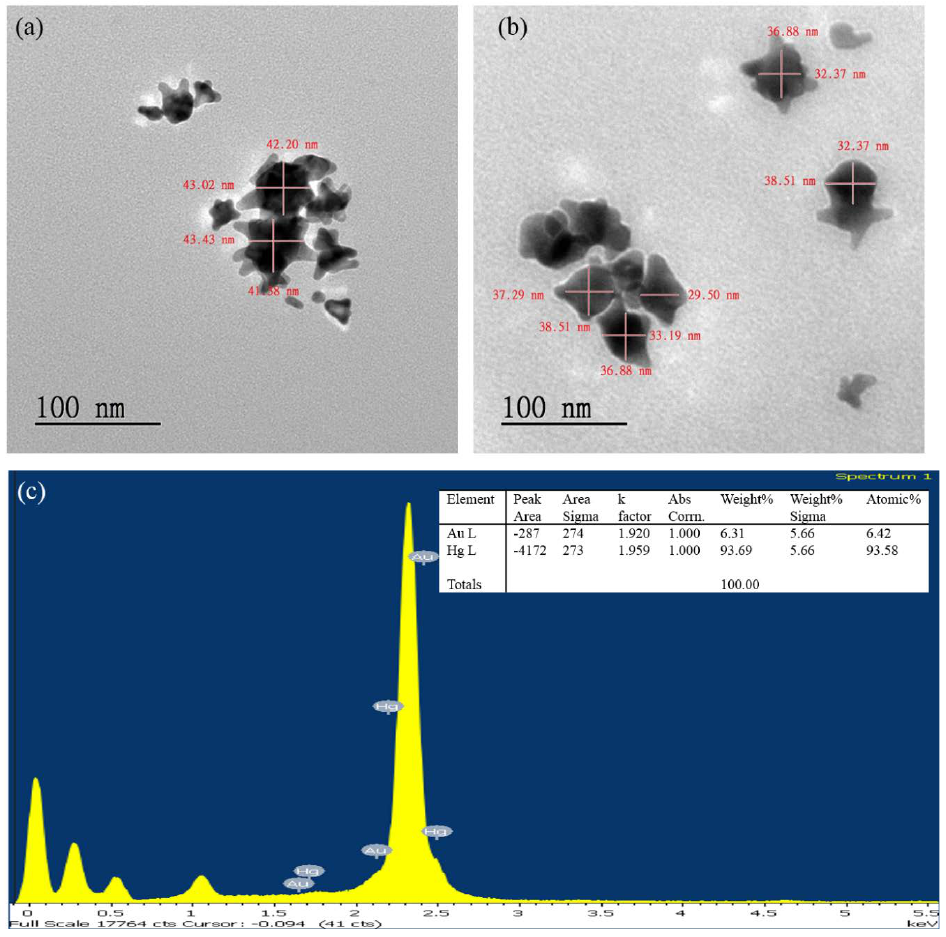
Figure 4. TEM images of the H-AuNS probe ( a ) without and ( b ) with Hg(II) (1.0 µ M) in the absence of HCl/Au(III)/H 2 O 2 solutions; ( c ) EDX spectrum of the H-AuNS probe with Hg(II) in the absence of HCl/Au(III)/H 2 O 2